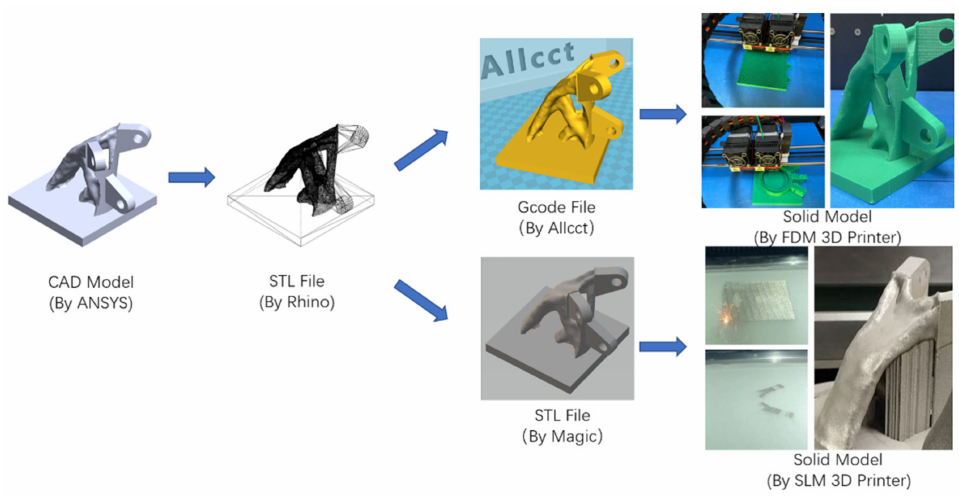
Figure 14. Additive manufacturing of the smoothing joint (images by Hui Wang).